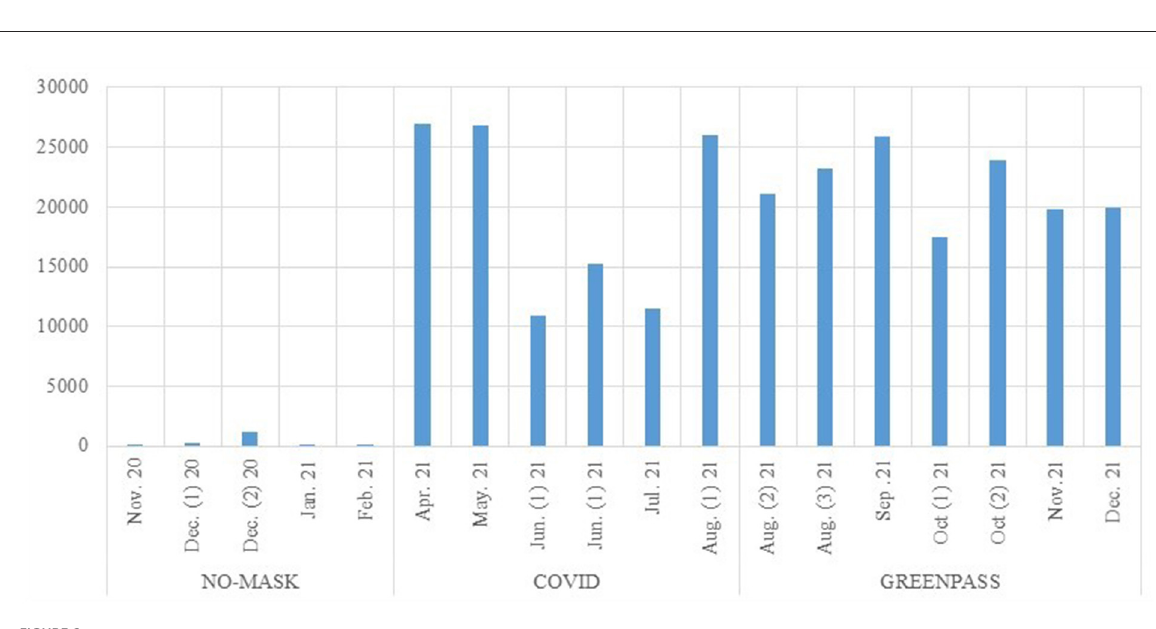
FIGURE6 Distribution of betweenness . Time series: November 2022–December